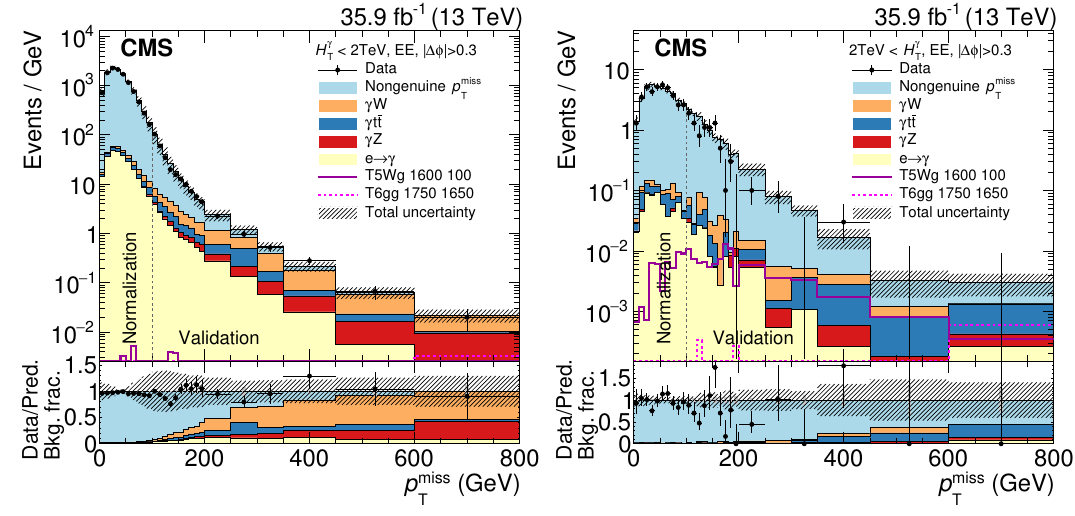
Figure 4 . Validation of the background estimation methods with photons reconstructed in the EE. The expectation for the T5Wg signal scenario with a gluino mass of 1600 GeV and a gaugino mass of 100 GeV and the T6gg signal scenario with a squark mass of 1750 GeV and a neutralino mass of 1650 GeV are shown. The low- (high-) H (cid:13) selection is shown on the left (right). Below the T p miss distributions, the data divided by the background prediction are shown as black dots, and the T relative background components are shown as coloured areas. The rightmost bin includes all events with p miss > 600 T